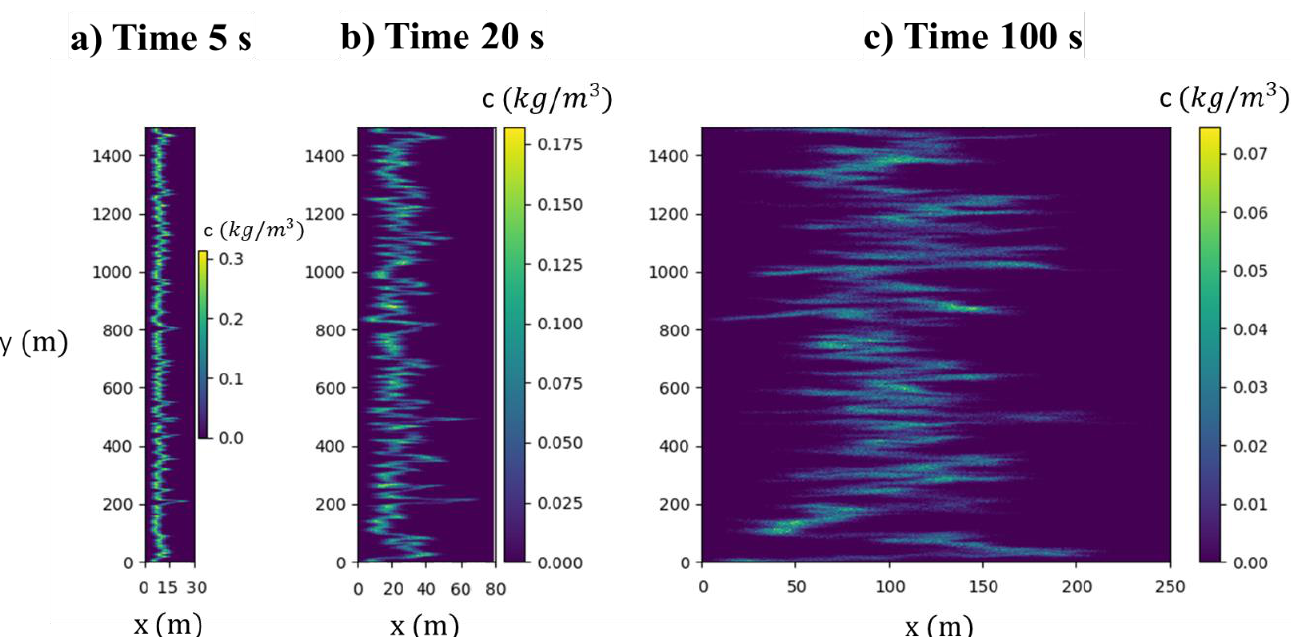
Figure 3. Spatial distribution of the solute concentration in RW model at times ( a ) 5 s, ( b ) 20, and ( c ) 100 s and at case Pe = 50. The spatial proportion between the x and y axis is 1:6.